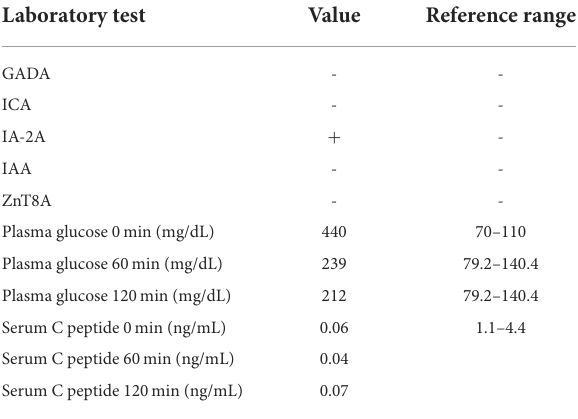
TABLE 2 Related autoantibodies and islet